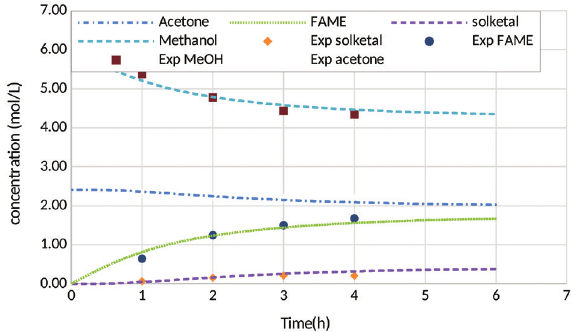
Figure 5: Prediction by kinetic model at 50°C, 0.5 of catalyst to oil molar ratio, and (1:4) of oil to acetone molar ratio, 10:1 of methanol to oil molar ratio